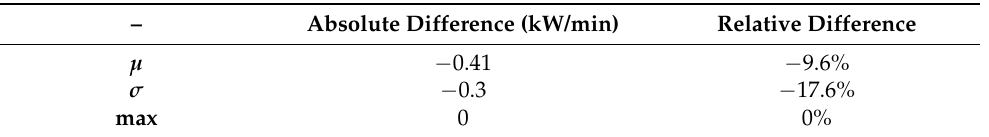
Table 15. Variation of daily peak of the absolute ramp of the active net power flow during May 2020 between Scenario C and Scenario B. µ : average value, σ : standard deviation, max: maximum value.